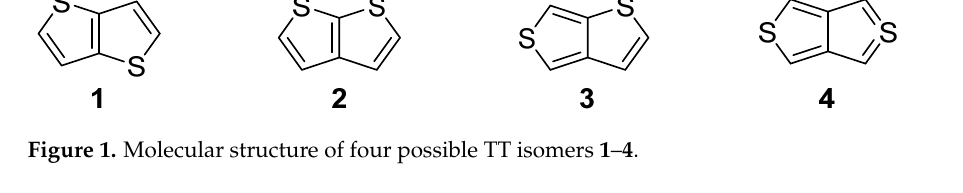
Figure 1. Molecular structure of four possible TT isomers 1 – 4 .